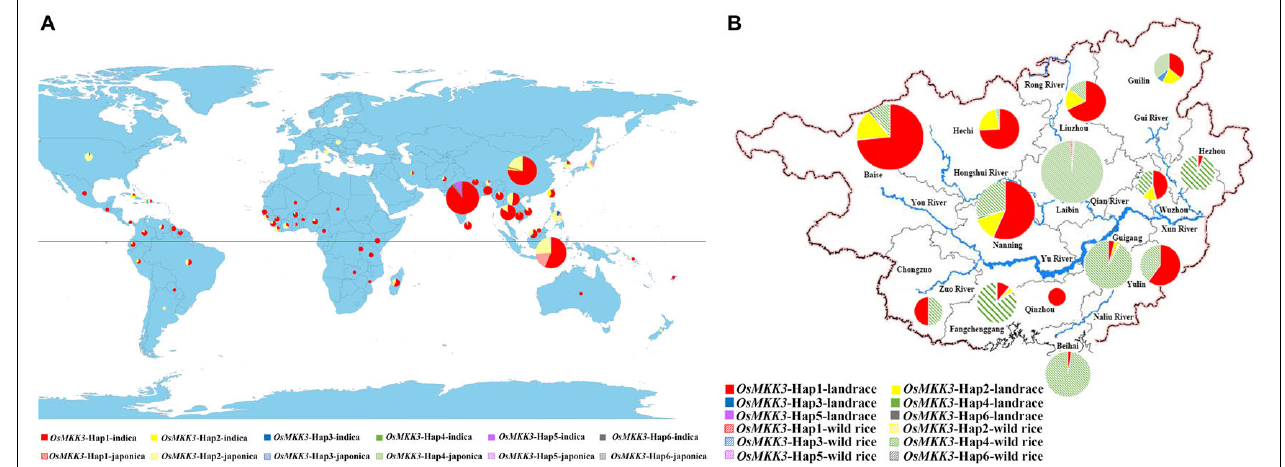
FIGURE 4 | Distribution of the main OsMKK3 haplotypes in wild rice and cultivated rice in the world and Guangxi province. (A) Geographic origin of OsMKK3. Hap1–6 is represented by red, yellow, blue, green, purple, and gray, respectively. The indica and japonica cultivars are denoted by solid and dashed circles, respectively. (B) Geographic origin of OsMKK3 in Guangxi province. Hap1–6 is represented by red, yellow, blue, green, purple, and gray, respectively. The rice landraces and wild rice cultivars are denoted by solid and dashed circles, respectively.